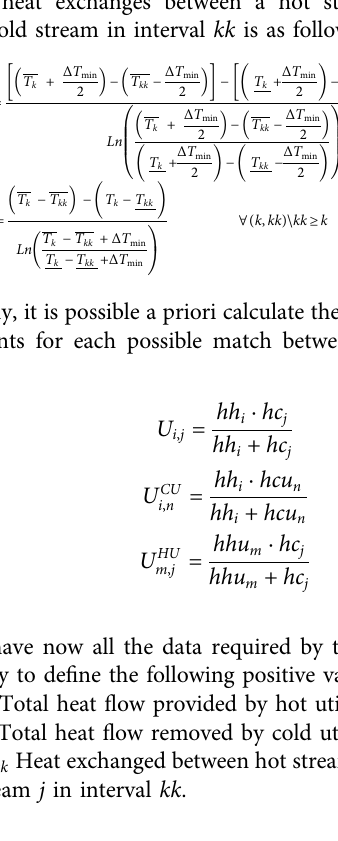
Frontiers in Chemical Engineering |